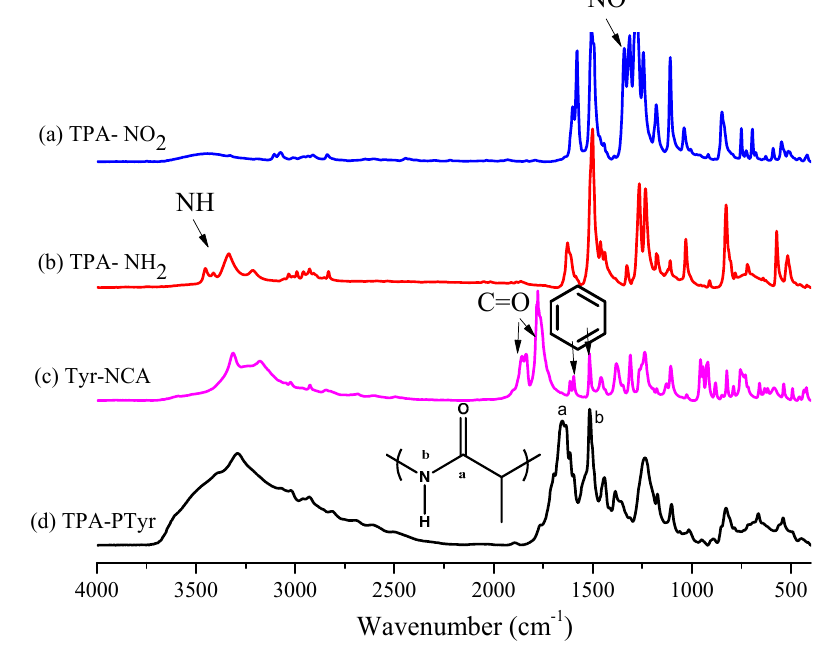
Figure 1. FTIR spectra, recorded at room temperature, of: ( a ) TPA-NO 2 ; ( b ) TPA-NH 2 ; ( c ) Tyr-NCA monomer; and ( d ) PTyr-TPA.